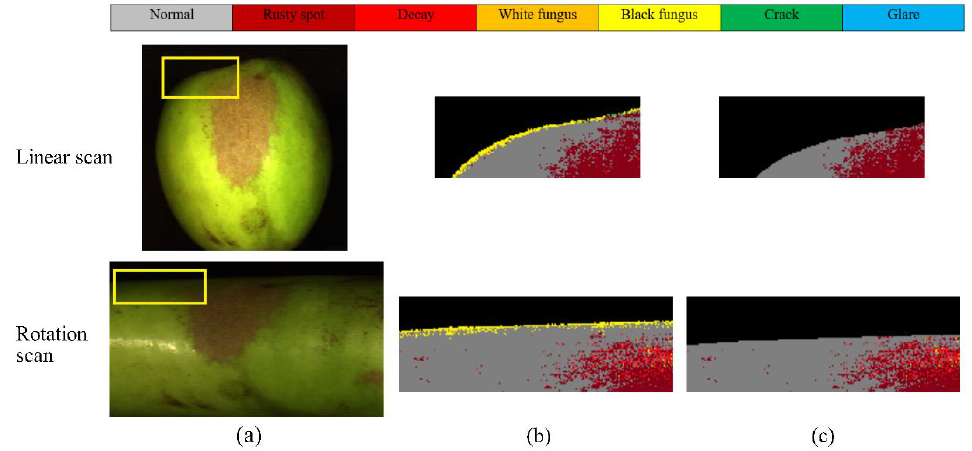
Figure 6. ( a ) Red, Green and Blue (RGB) images of jujube specimen, ( b ) predictive results shown in the original masks and ( c ) predictive results shown in the new masks created by eroding approximately 5% of the original